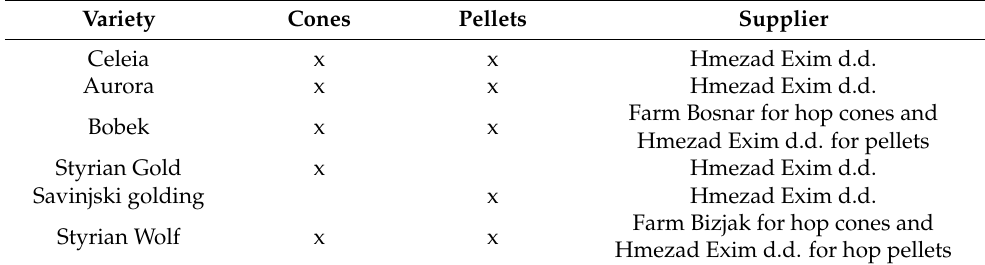
Table 1. Information about hop